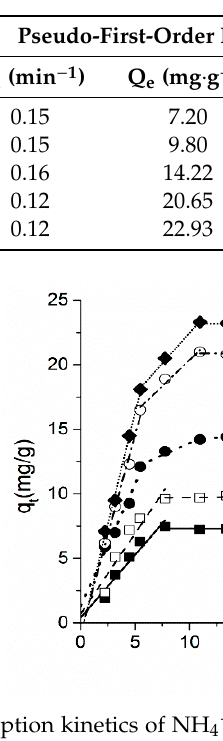
Figure 7. Adsorption kinetics of NH 4+ -N on the five kinds of biochar fitted with the pseudo-first-order ( a ) and pseudo-second-order models ( b ). Table 3. Kinetic parameters of the pseudo-first-order and pseudo-second-order equations for NH 4+ - N adsorption on the five kinds of biochar.